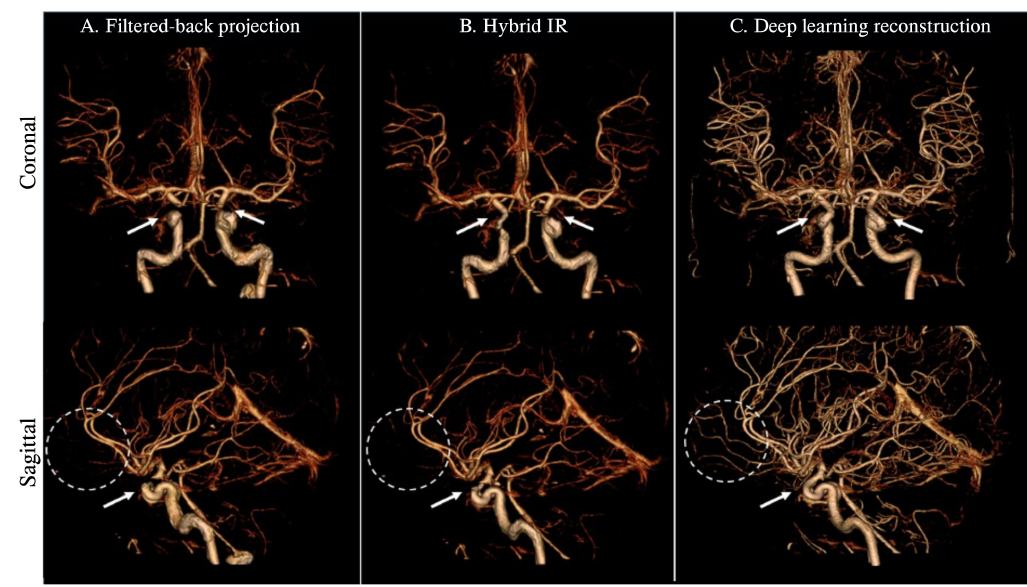
Fig. 5. Volume rendering of brain vessels extracted by bone removal from only CTA images. The volume-rendered image of brain CTA using deep learning reconstruction (C) shows an increased number of cortical branches and completeness of clinoid and supraclinoid segments of ICA (white arrows) compared to hybrid iterative (B) and filtered back projection (A). In addition, deep learning reconstruction allows more conspicuous visualization of the major terminalbranches, includingfrontobasalandfrontopolararteries(dashedcircle). Atthesametime, theyarenotseeninthehybriditerativereconstruction(IR) and filtered back projection. Deep learning reconstruction provided significantly greater enhancement on small cortical branches of brain arteries, resulting in markedly improved vascular visualization. The images were views in the same window level and width.